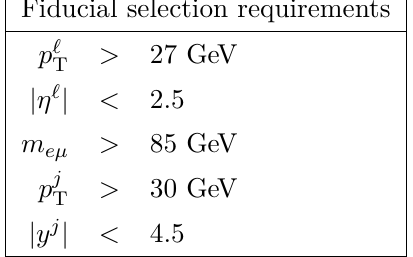
( η ‘ ) refers to the T ( y j ) to the transverse momentum T